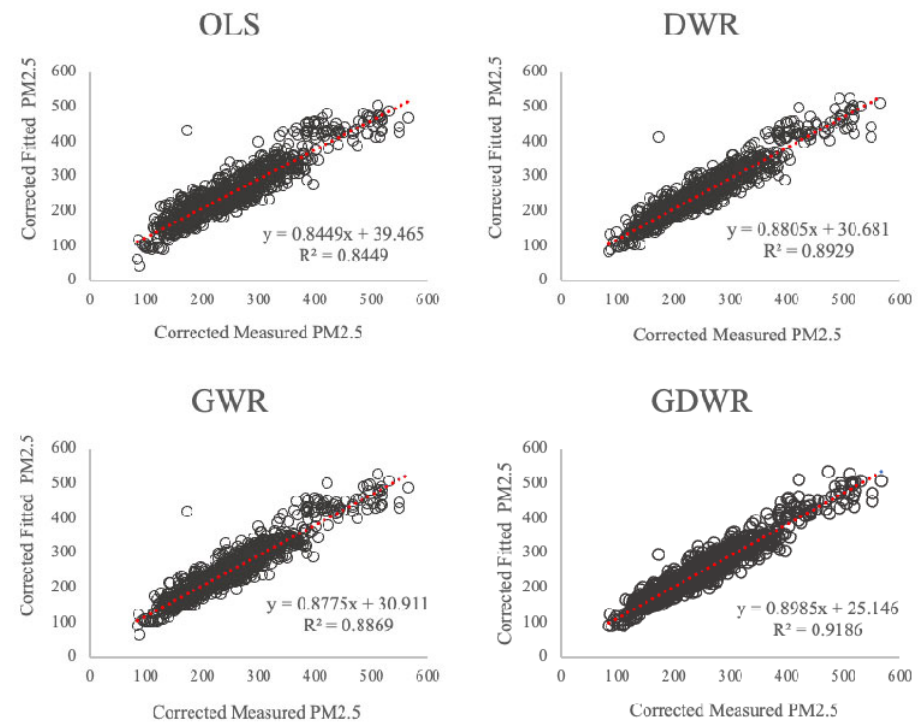
Figure 9. Scatter plot between corrected measured and corrected fitted PM 2.5 concentrations for model fitting. According to the above scatter plot of the model fitting results, PM 2.5 and the other independent variables all exhibited a notable fitting effect, and the PM 2.5 fitting accuracy between each model and the original calibrated data was above 0.8, indicating the valid ‐ ity of the models. Moreover, a comparison of the effects of these four models also re ‐ vealed that the accuracy values followed the order of GDWR>DWR>GWR>OLS, indi ‐ cating that the weighted regression model considering the annual direction achieved a higher fitting effect. After recalculating the data into three segment groups by corrected PM 2.5 values (0~200, 200~400, 400~600), the statistical results of each model are shown in Figure 10. As seen in the figure, all models have the highest fitting accuracy in the PM 2.5 interval (200, 400), followed by the PM 2.5 interval (200, 400), and the worst in the high PM 2.5 interval (400,600), which is inversely proportional to the amount of effective training data in the interval. The number of effective training data for the high PM 2.5 value is significantly less than the other two intervals, resulting in a model accuracy below 0.5. Comparing be ‐ tween models, the GDWR model ranks first in all intervals, especially in the case of low training data, reflecting its strong resistance to missing training data.